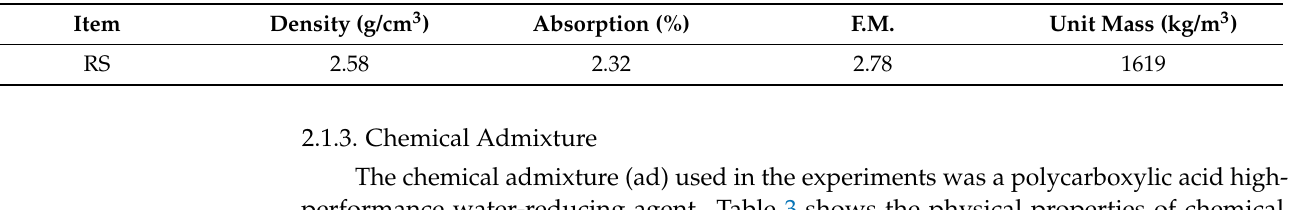
Table 2. Physical properties of fine aggregate.